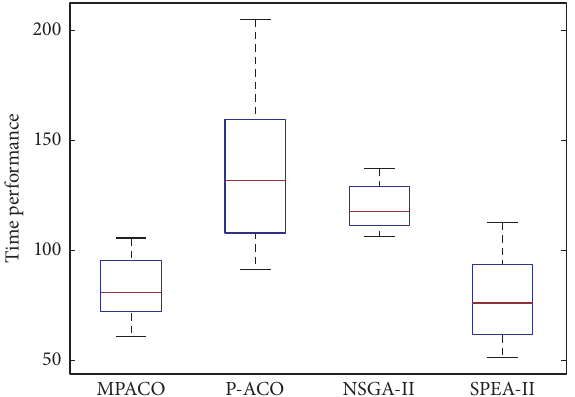
Figure 10: Boxplot of time performance on Scale 3 (in